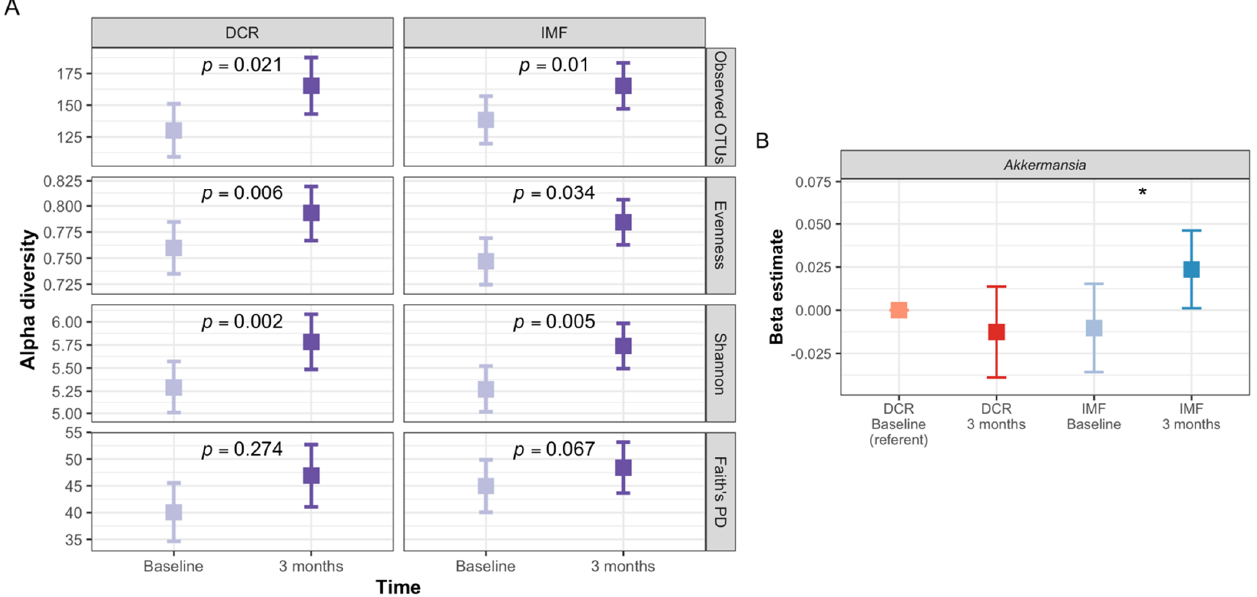
Figure 6. Changes in the gut microbiota of DRIFT2 participants from baseline to three months by intervention group. ( A ) This plots shows the change from baseline to three months by intervention group of four indices of alpha-diversity: Observed OTUs, Evenness, Shannon diversity index, and Faith’s Phylogenetic Diversity (PD), which reflect different aspects of alpha-diversity, such as the richness, evenness, and phylogenetic relatedness of the organisms detected in the samples. All alpha-diversity indices, except Faith’s PD, showed significant increases over time in both DCR ( n = 47 samples from 25 individuals) and IMF ( n = 64 samples from 34 individuals) groups based on linear mixed models by intervention group, controlling for age, sex, and time. There were not significant differences between intervention groups (DCR versus IMF) in the change in alpha-diversity over time (interaction p -values ≥ 0.48). ( B ) Only one gut microbiota taxon ( Akkermansia ) showed significant differences between intervention groups in terms of the relative abundance change from baseline to three months. The y-axis shows the regression estimate from longitudinal models (using the ANCOM method using the ANCOM method, controlling for age, sex, intervention group, time, and an interaction between intervention group and time, for n = 104 samples from 52 individuals; 22 DCR and 30 IMF) for the change in proportion relative abundance relative to DCR at baseline. The * indicates significant change over time within the intervention group.